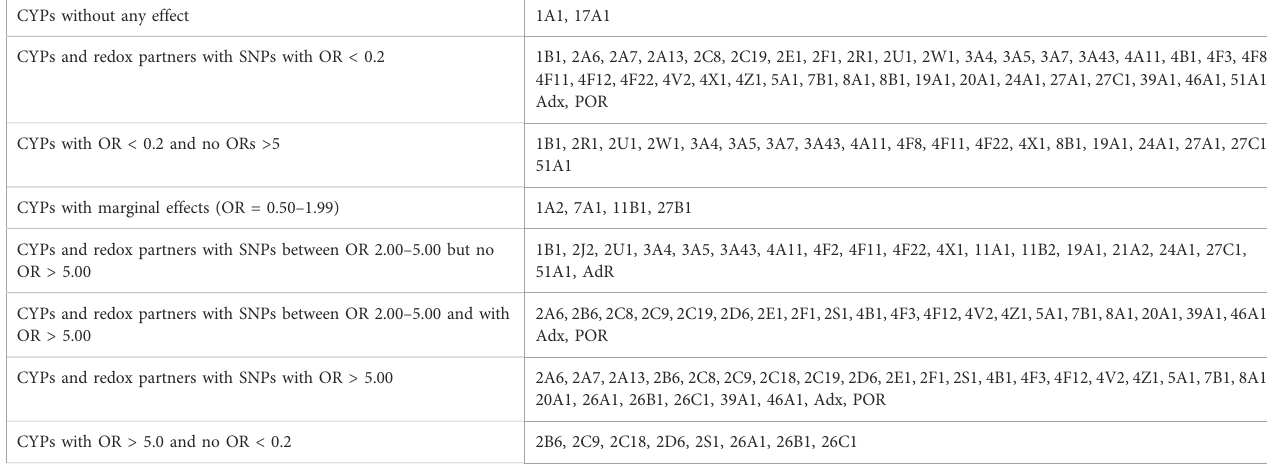
TABLE 1 Different effects of SNPs of various CYPs and redox partners on Parkinson ’ s disease. CYPs without any